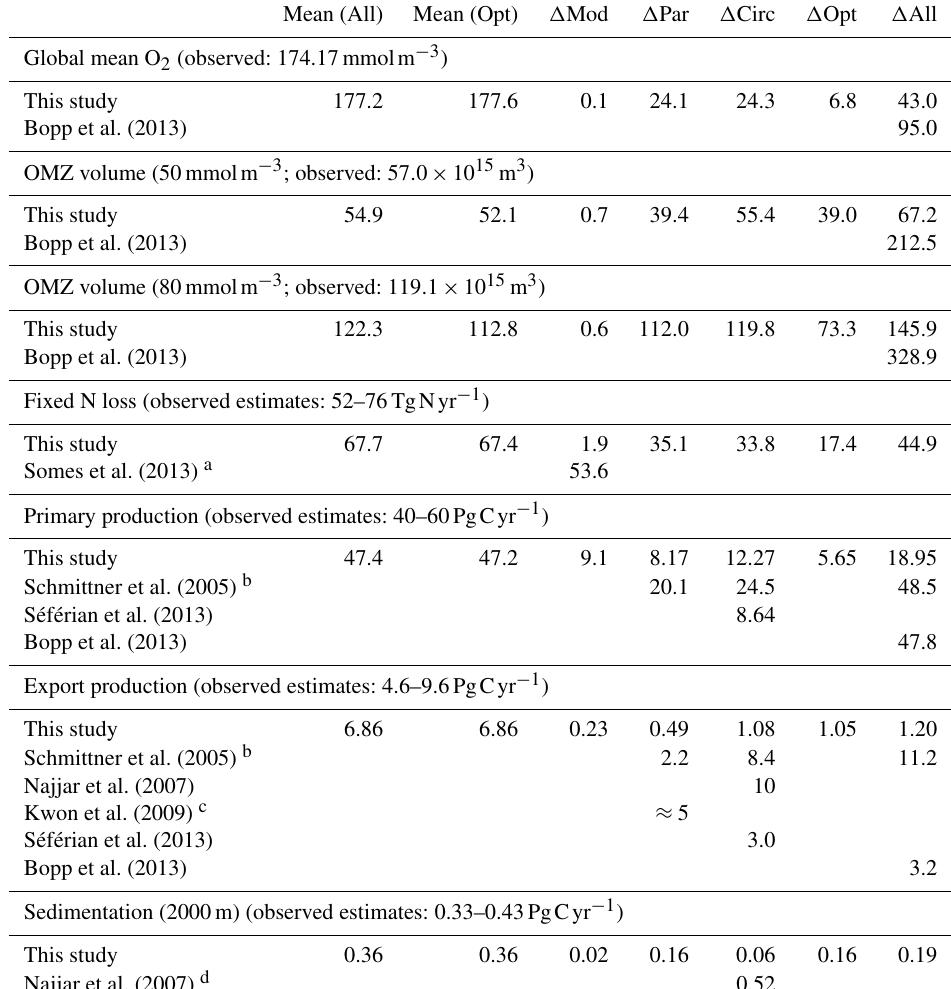
Table 3. Mean (across all experiments and optimal models) and range of variation in global biogeochemical model properties and fluxes across different parameter sets (circulation constant; (cid:49) Par), and different circulations (parameters constant; (cid:49) Circ), as well as across the five different optimal models MIT28 ∗ , ECCO ∗ , uHigh ∗ , U20 ∗ and U17.5 ∗ ( (cid:49) Opt). (cid:49) Mod shows the difference between MIT28 ∗ of this study and the model RetroMOPS of Kriest (2017). Observed oxygen and OMZ volume from Garcia et al. (2006b, mapped onto ECCO grid); observed global flux ranges derived from estimates by Carr et al. (2006, primary production), Dunne et al. (2007, export production), Lutz et al. (2007, export production, radiogen. calib.), Honjo et al. (2008, mean particle flux), Guidi et al. (2015, particle flux), Eugster and Gruber (2012, median fixed-nitrogen loss), and Somes et al. (2013, fixed-nitrogen loss of best data-constrained model). Mean (All) Mean (Opt) (cid:49) Mod (cid:49) Par (cid:49)